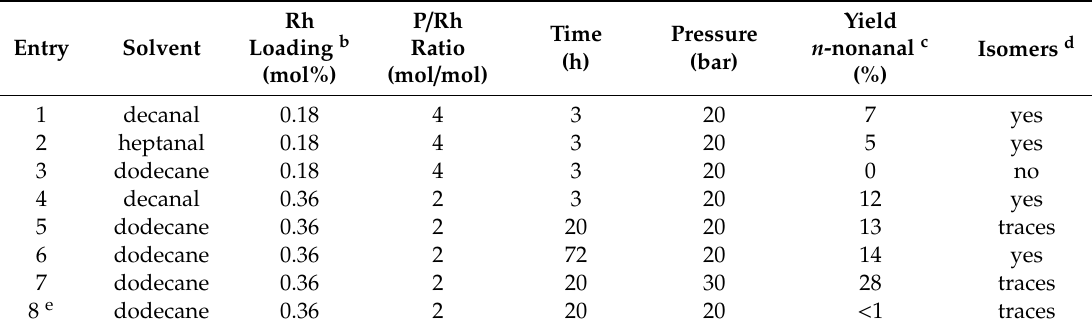
Table 1. Hydroformylation of 1-octene using Rh-nixantphos@CCM catalyst a